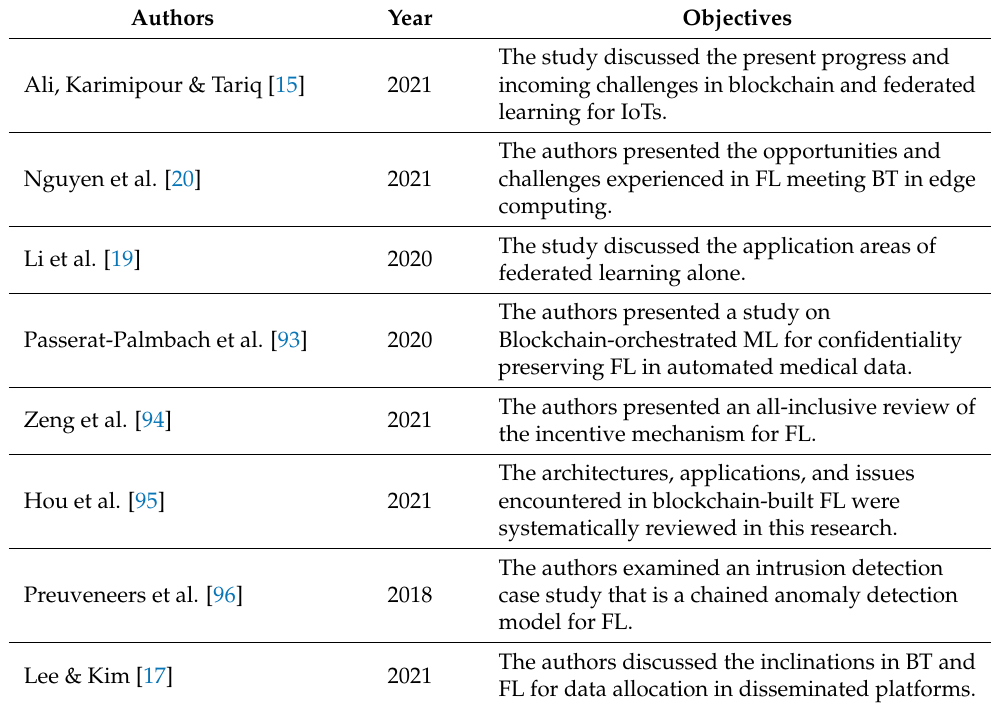
Table 12. Summary of some related